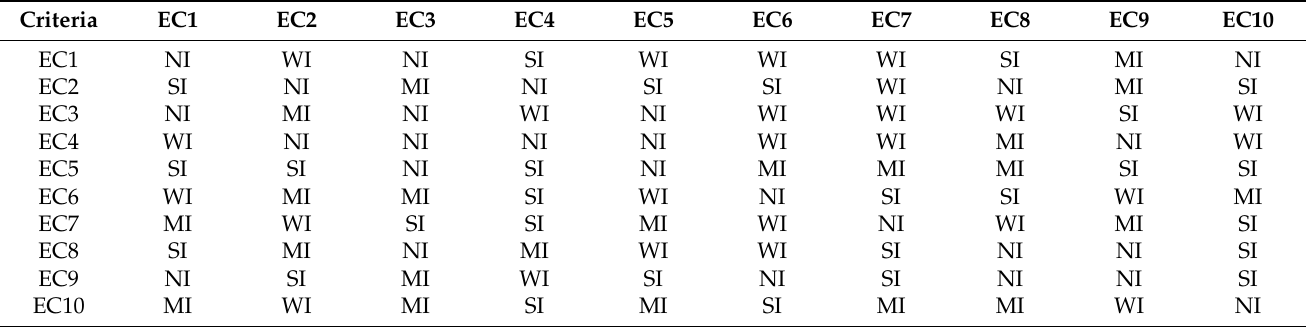
Table A3. Linguistic pairwise comparison of criteria by Expert